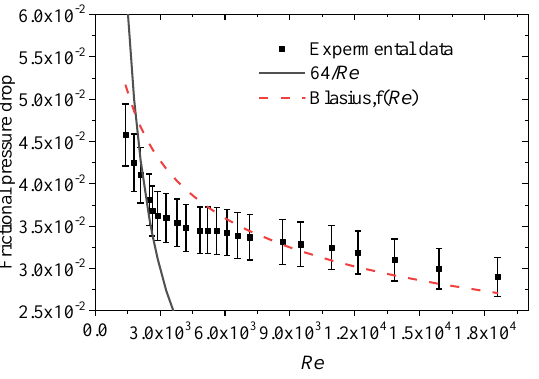
Figure 10. Drag coefficient with experimental data under constant Re .